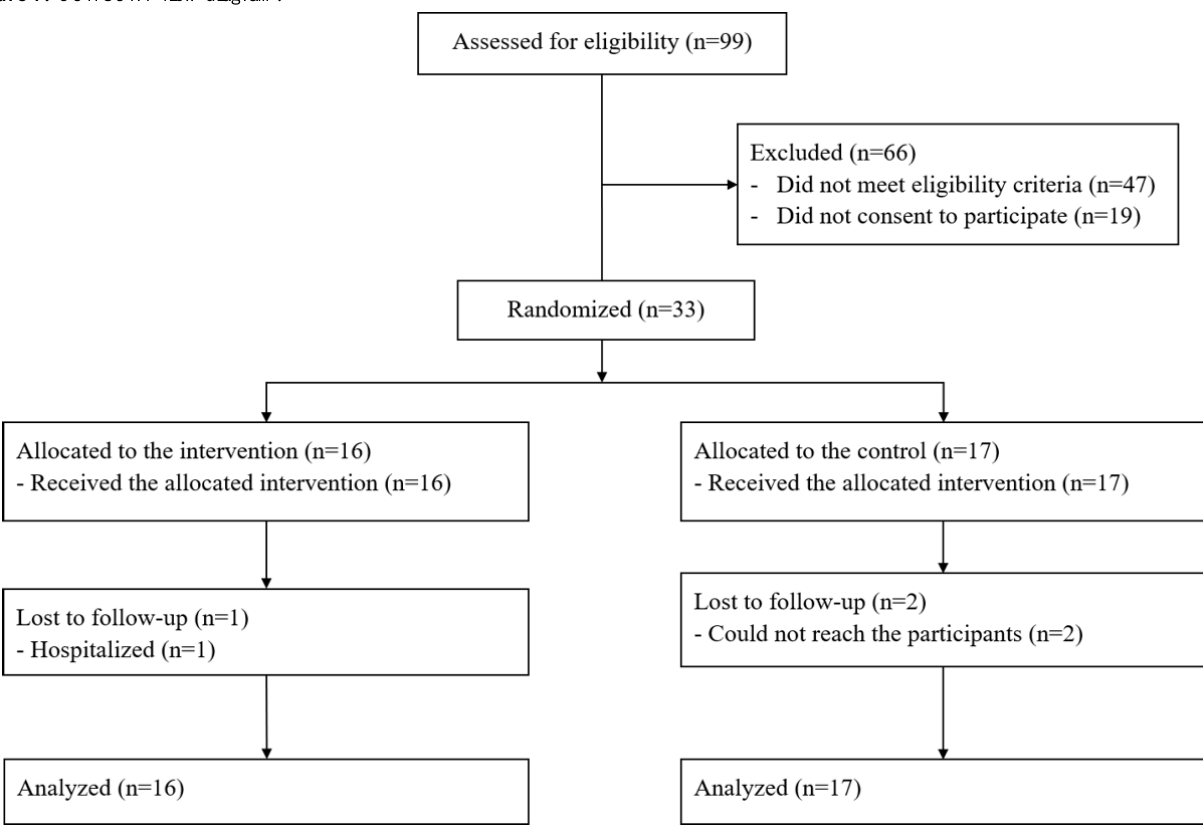
Figure 1. CONSORT flow